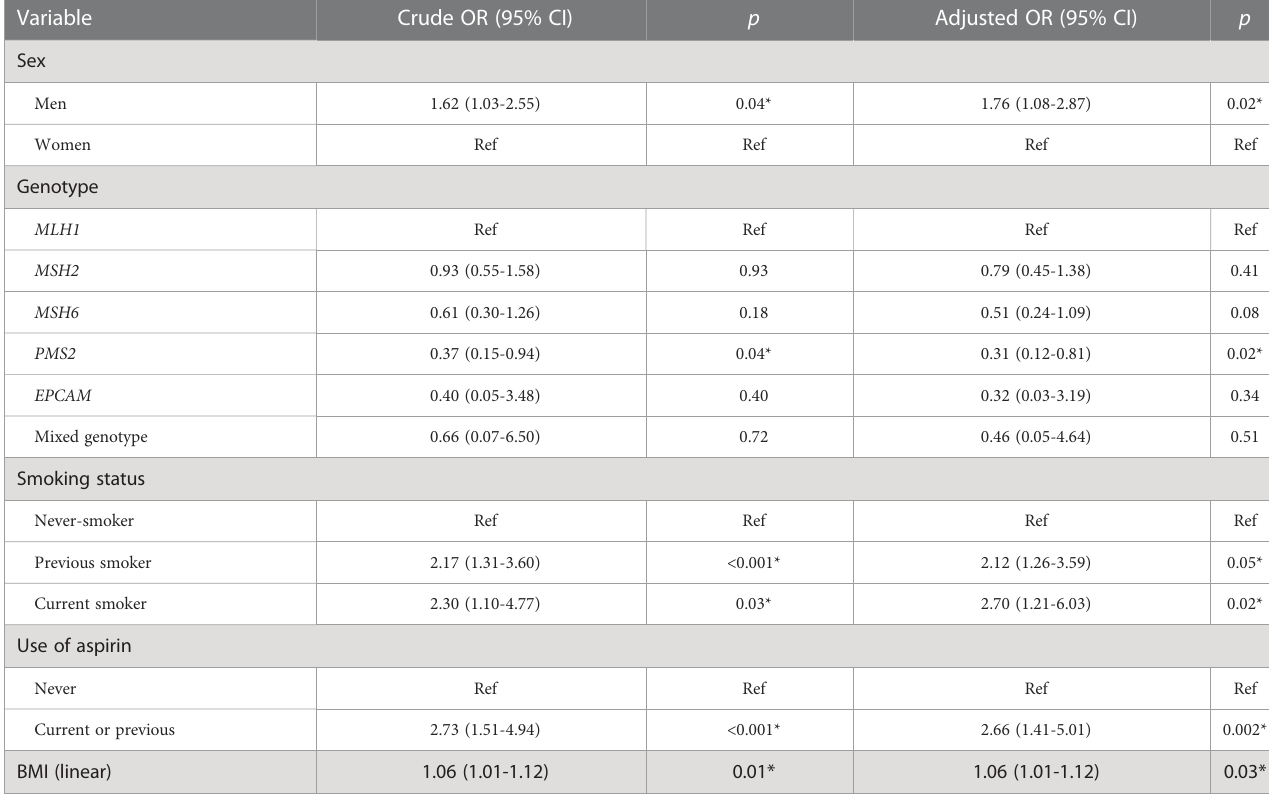
TABLE 2 Risk factors for developing